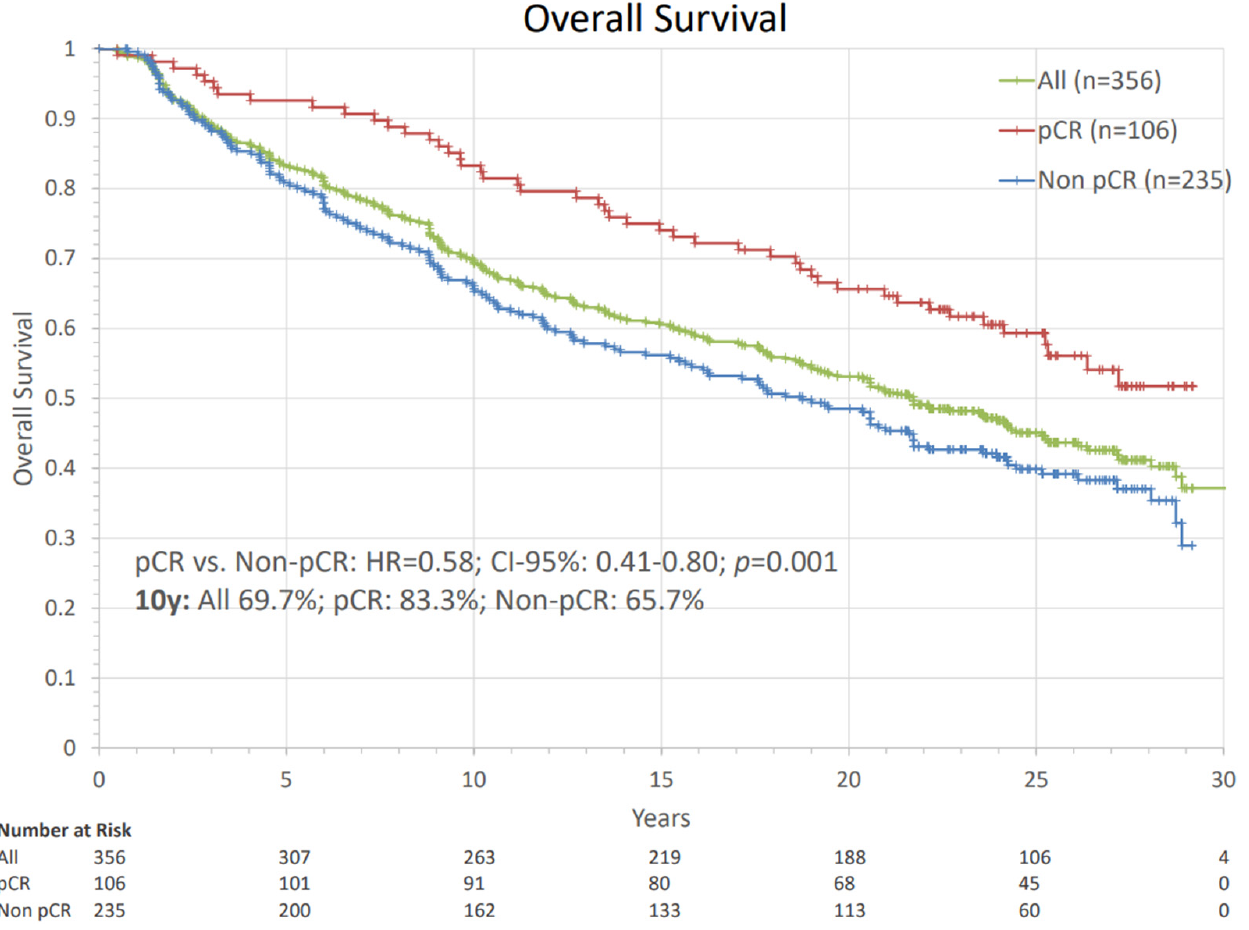
Figure 1. Overall survival of the whole cohort and groups separated by pathological complete response. The comparison using Cox regression analysis is presented with hazard ratio, the corresponding confidence interval, and p -value. Patients with ALND before systemic therapy were excluded from pCR analysis. pCR: pathologic complete response, HR: hazard ratio, ALND = axillary lymph node dissection, n: number of patients.